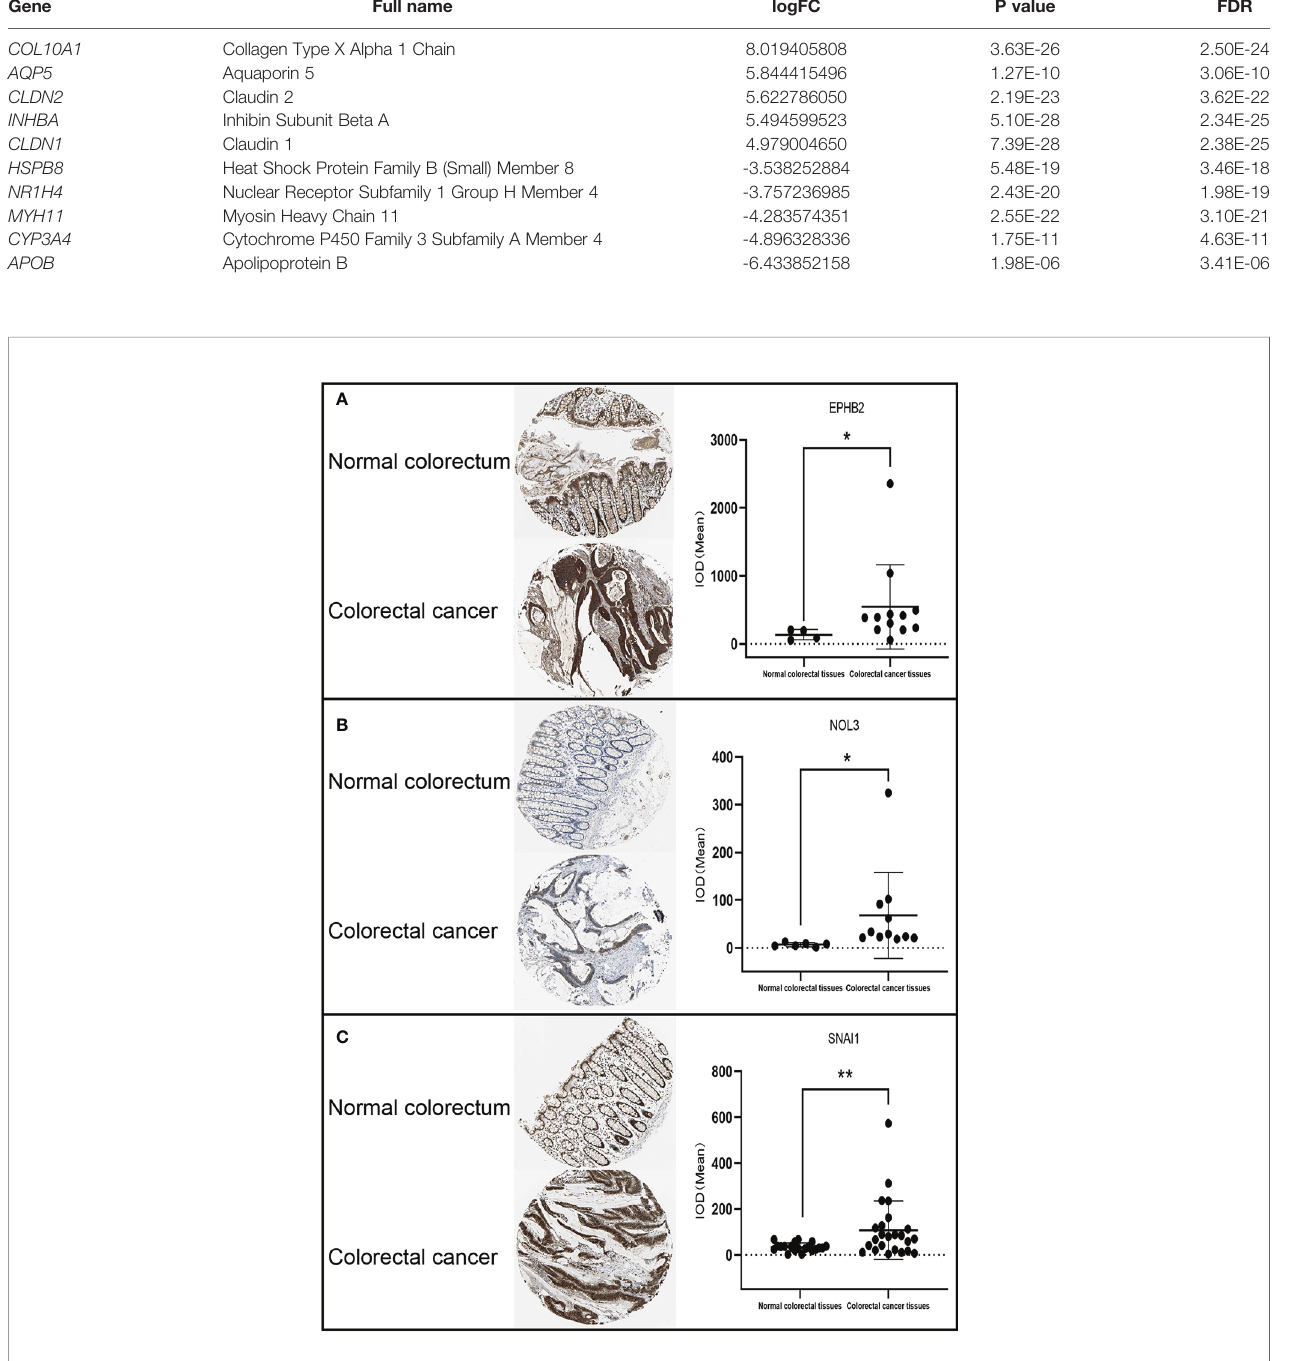
FIGURE 4 | IHC analysis of EPHB2 (A) , NOL3 (B) , and SNAI1 (C) in CRC tissues. * p < 0.05, ** p < 0.01.